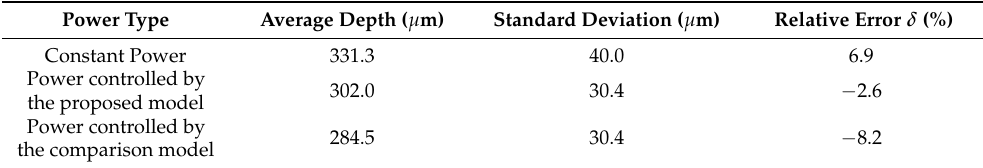
Table 9. The average depth results of the 5-axis variable-angle straight groove engraving.